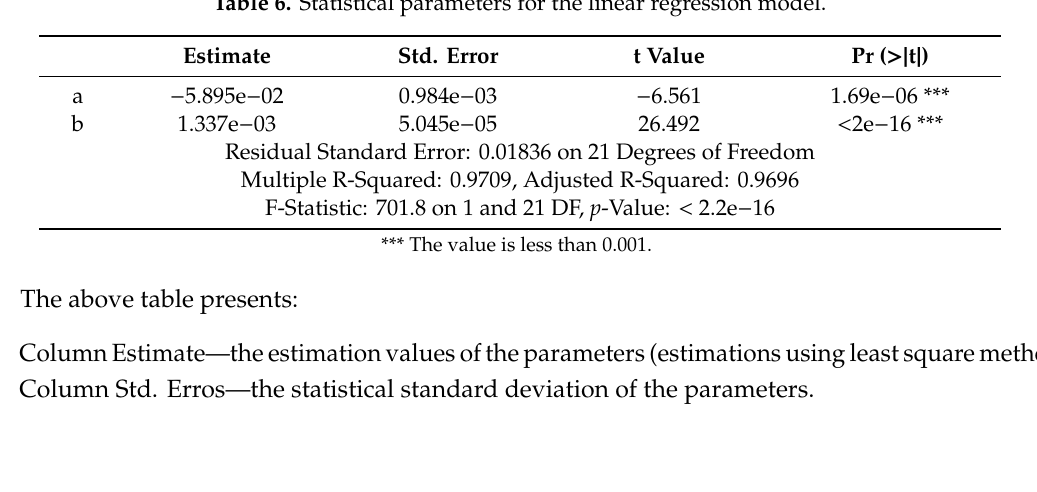
Table 6. Statistical parameters for the linear regression